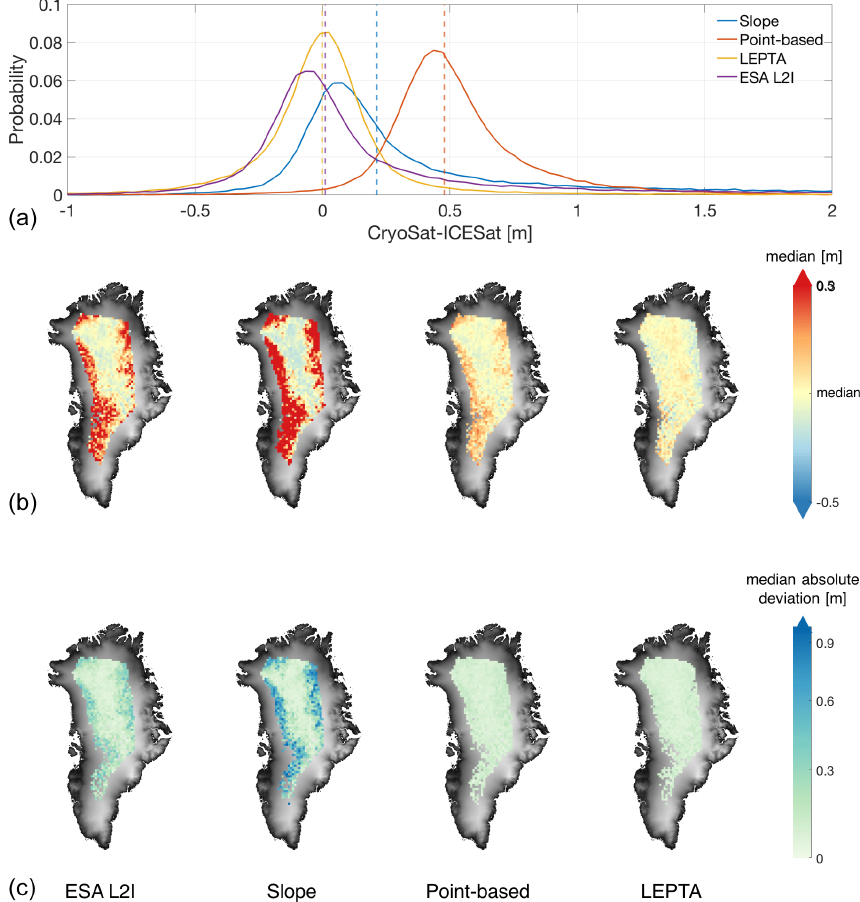
Figure 4. (a) Probability distribution of height difference between CryoSat-2 and the ICESat-2, before removing the outliers. The probability distribution is plotted with all data samples but restricted to [ − 1m, 2m] for visualisation (for better illustration of the skewness and large outliers, please refer to Appendix B). Vertical lines show the median value per method. (b, c) Spatial distribution of median and median absolute deviation of the height difference per tile of 25km × 25km, after removing the outliers. To enhance the visibility of the maps, the median value of each method is subtracted in (b) . The colours of the median absolute deviation plots are on a logarithmic scale. The spatial distribution results from left to right are obtained by ESA L2I products, the slope method, the point-based method, and LEPTA, with the 1km × 1km DEM covering Greenland (Helm et al., 2014a, b) as